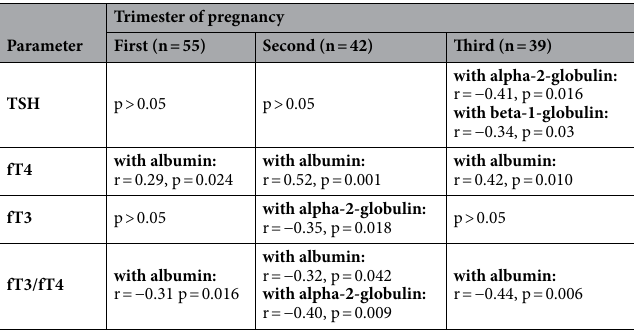
Table 2. Correlations between thyroid hormone levels and the serum concentrations of six major protein fractions across normal pregnancy. Significant relationships (p <0.05) are marked in bold.